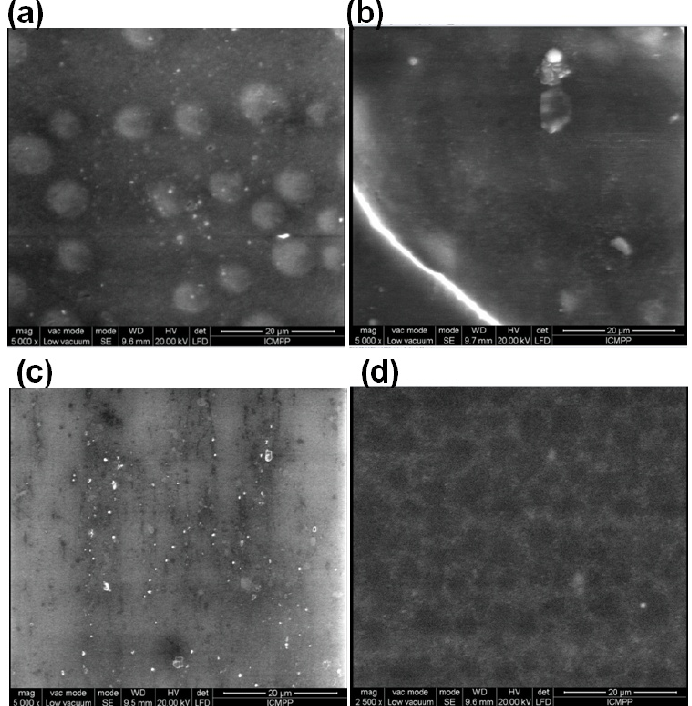
Figure 8. Scanning electron microscopy (SEM) image ofmPSF/mMWCNTs composite system nanocomposite containing different filler amount of mMWCNTs: ( a ) 0.5 wt%, ( b ) 1 wt%, ( c ) 2.5 wt%, and ( d ) 5 wt%.